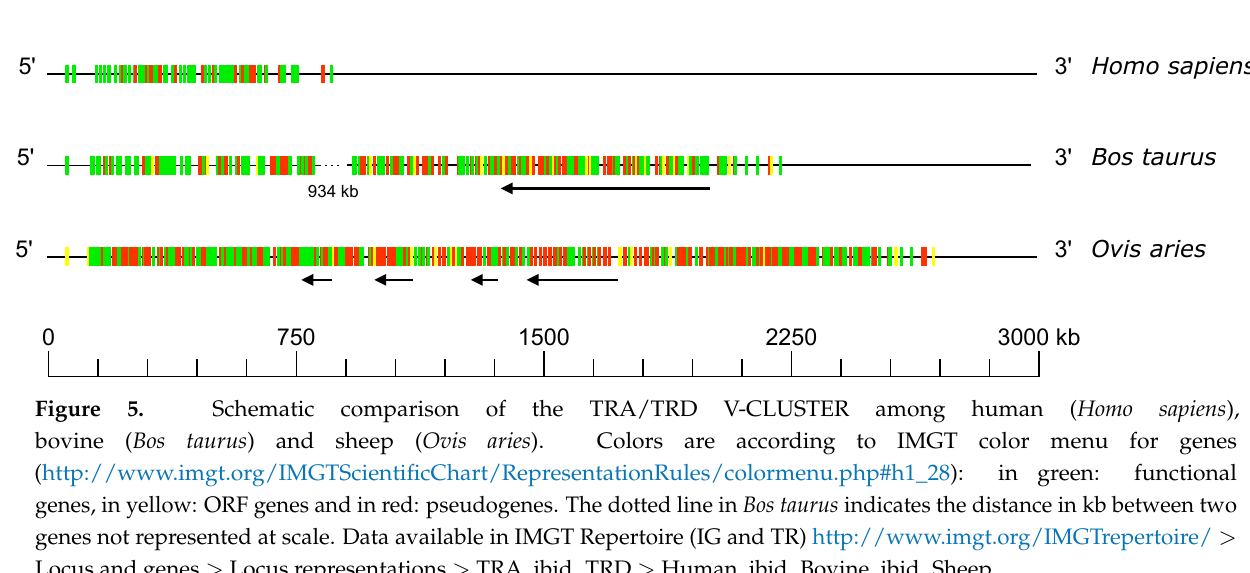
Figure 5. Schematic comparison of the TRA/TRD V-CLUSTER among human ( Homo sapiens ), bovine ( Bos taurus ) and sheep ( Ovis aries ). Colors are according to IMGT color menu for genes (http://www.imgt.org/IMGTScientificChart/RepresentationRules/colormenu.php#h1_28): in green: functional genes, in yellow: ORF genes and in red: pseudogenes. The dotted line in Bos taurus indicates the distance in kb between two genes not represented at scale. Data available in IMGT Repertoire (IG and TR) http://www.imgt.org/IMGTrepertoire/ > Locus and genes > Locus representations > TRA, ibid. TRD > Human, ibid. Bovine, ibid.